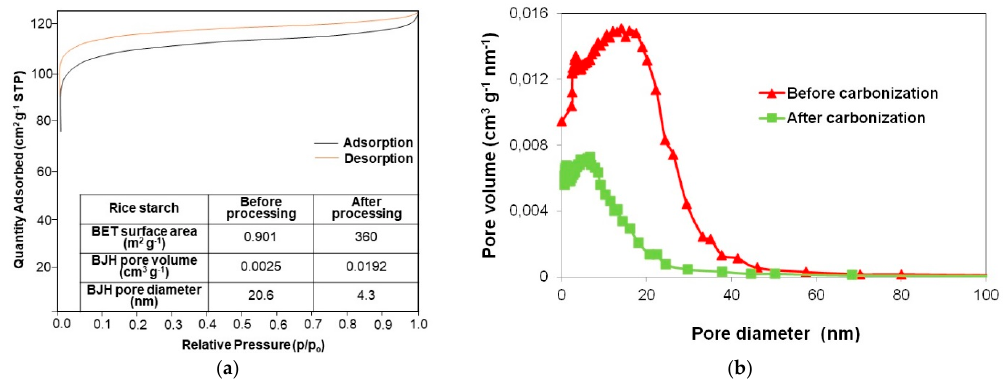
Figure 4. N 2 adsorption/desorption isotherms for rice starch-derived carbon ( a ) and compared pore size distribution for the obtained materials ( b ).